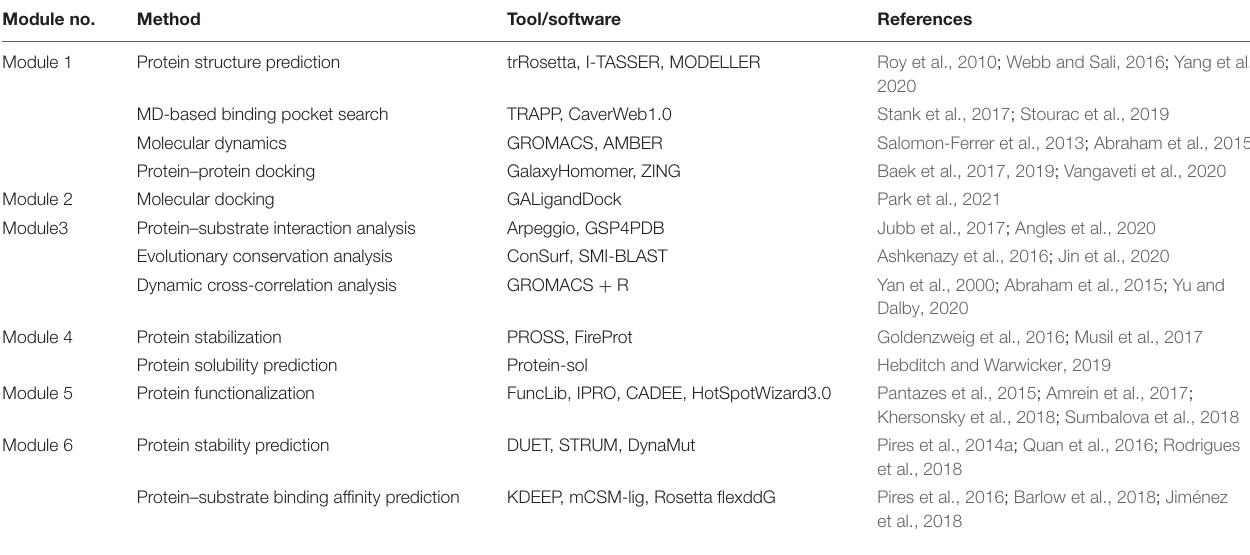
TABLE 1 | State-of-the-art software and online tools for computational protein engineering pipelines. Module no.